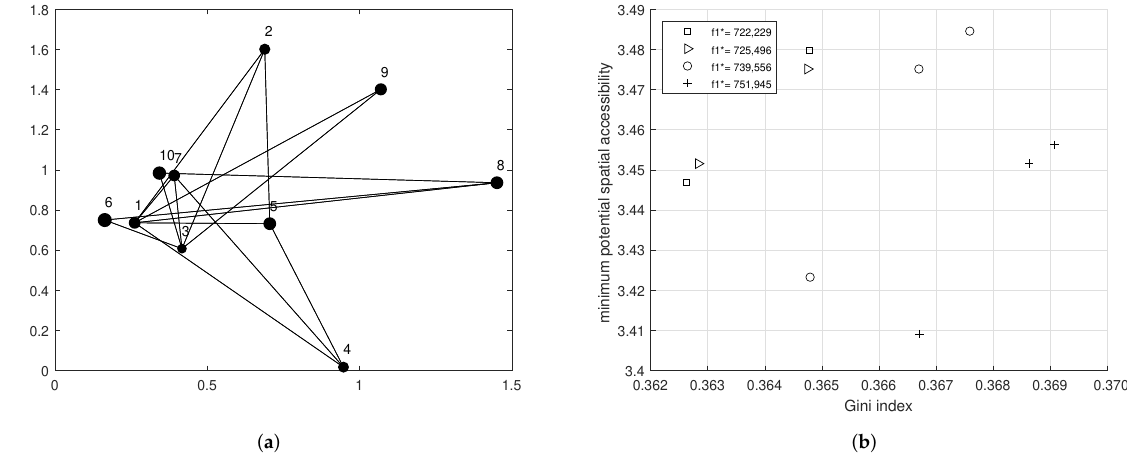
Figure 6. A randomly generated instance 2 for: ( a ) spatial zone distribution; and ( b ) non-dominated • Pareto solutions when k = 7; where 1 to 10 are the geographical zones, with sketching a discrete center whose diameter is proportional to the demand for healthcare centers in the indicated zone; and the indicated optimum coverage level f ∗ 1